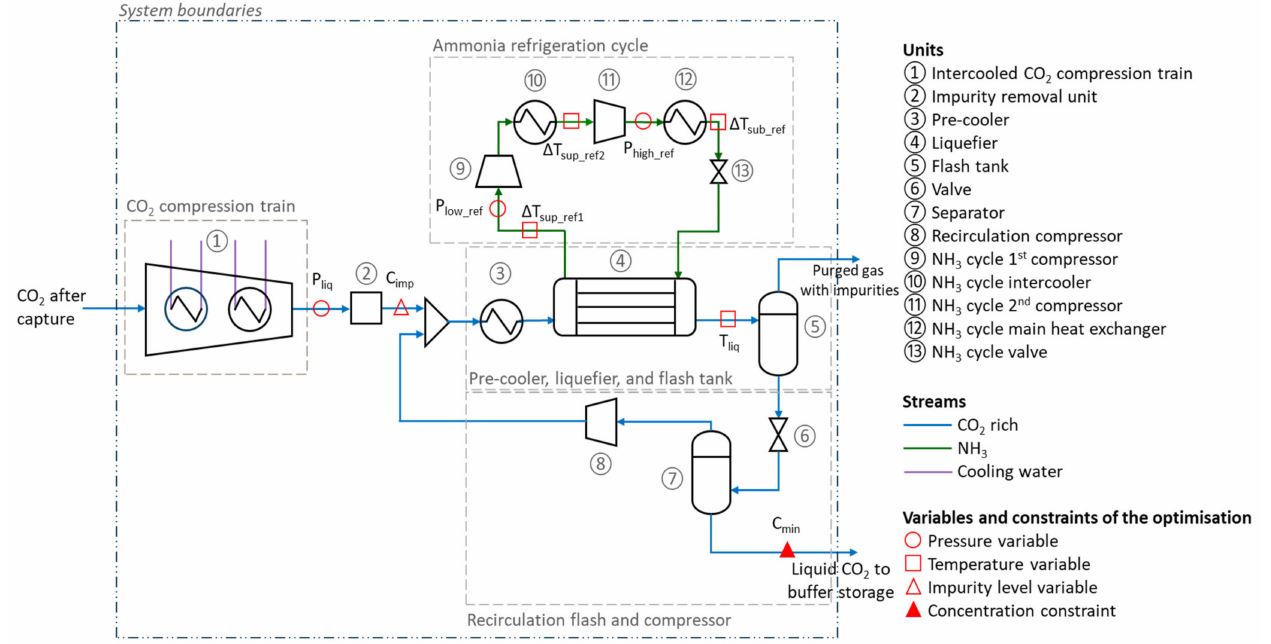
Figure 2. Process layout adopted for CO 2 liquefaction analysis